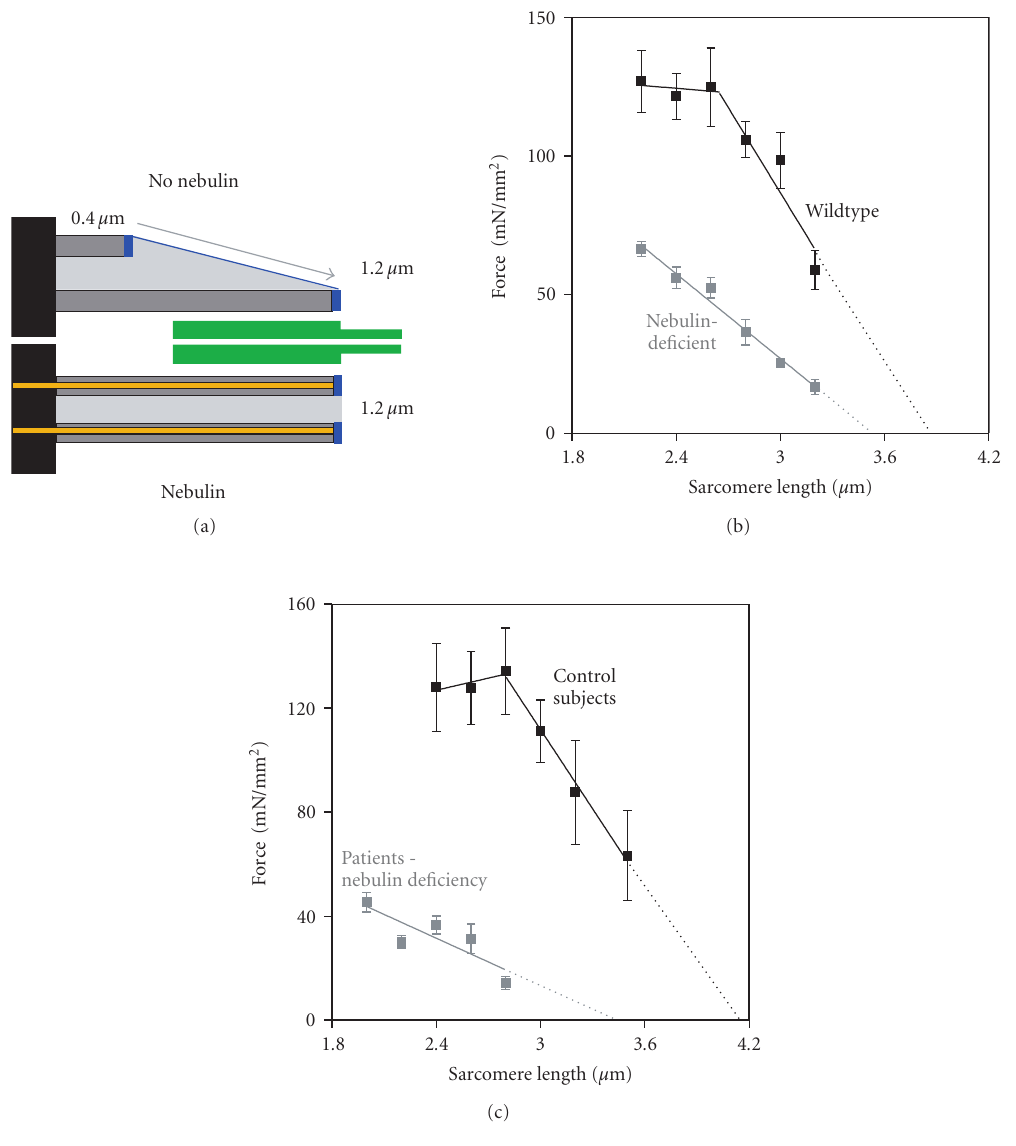
Figure 2: (a) Schematic illustrating the range of thin filament lengths found in nebulin-deficient muscle fibers. Immunoelectron microscopy [14] showed that thin filament lengths in wildtype tibialis cranialis muscle are a constant 1.2 μ m, but in nebulin-deficient muscle are on average ∼ 0.8 μ m and range from ∼ 0.4 to 1.2 μ m. (b) The force-sarcomere length relation of murine wt muscle fibers has a characteristic force plateau followed by a descending limb. The force-sarcomere length relation of nebulin-deficient fibers is shifted leftward compared to wt fibers, and the force plateau is absent. (c) Similarly, the force-sarcomere length relation of nebulin-deficient human muscle fibers (dissected from biopsies obtained from patients with nemaline myopathy) is shifted to the left, and the force plateau is absent as well [16].